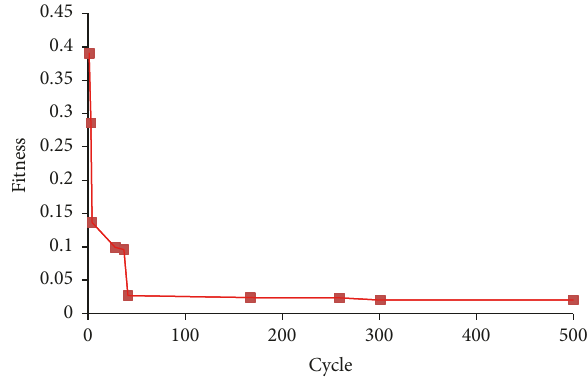
Figure 7: Fitness variation with increased cycles in the ABC